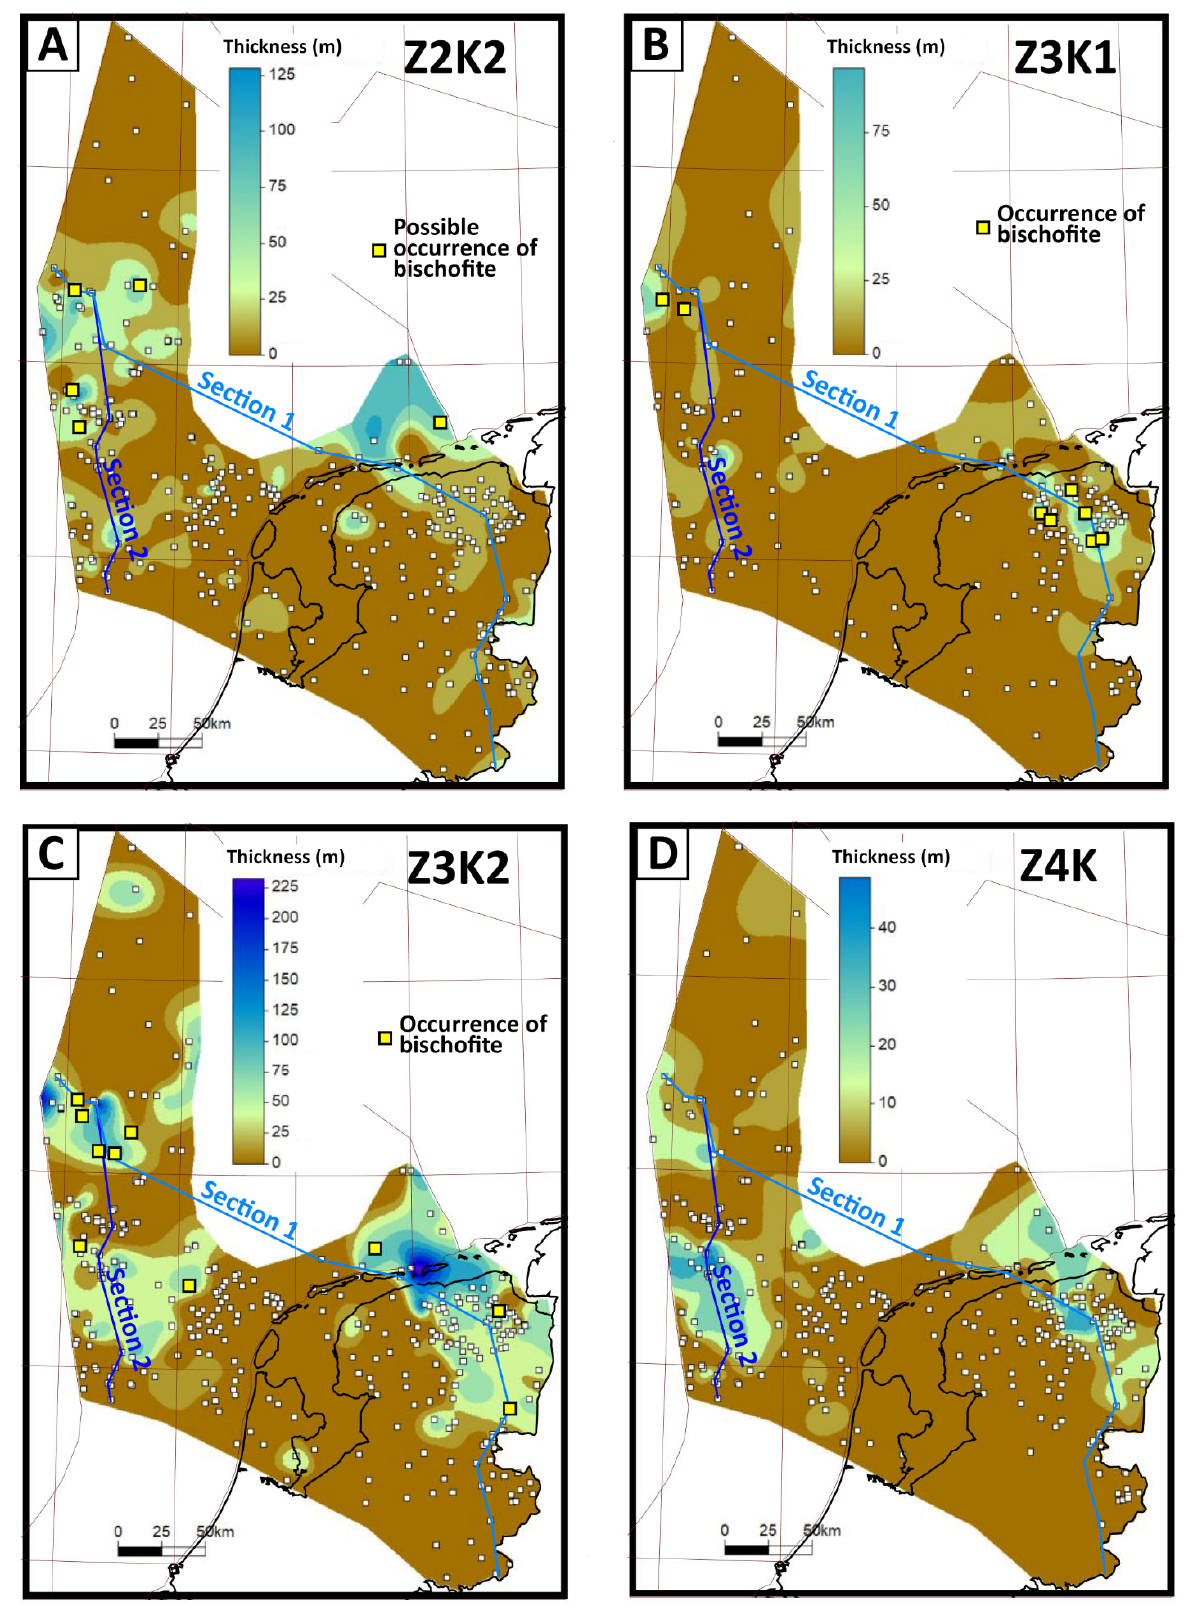
Figure 6. Isopach maps of Z2K2 ( A ), Z3K1 ( B ), Z3K2 ( C ) and Z4K ( D ) units of the Zechstein group (see Figure 6A for the localization of the strata intervals on the lithologic column).